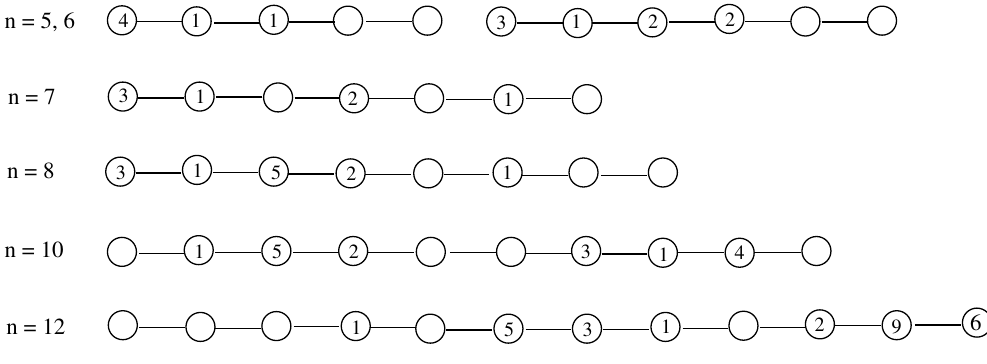
for n = 5 , 6 , 7 , 8 , 10 , 12 . n